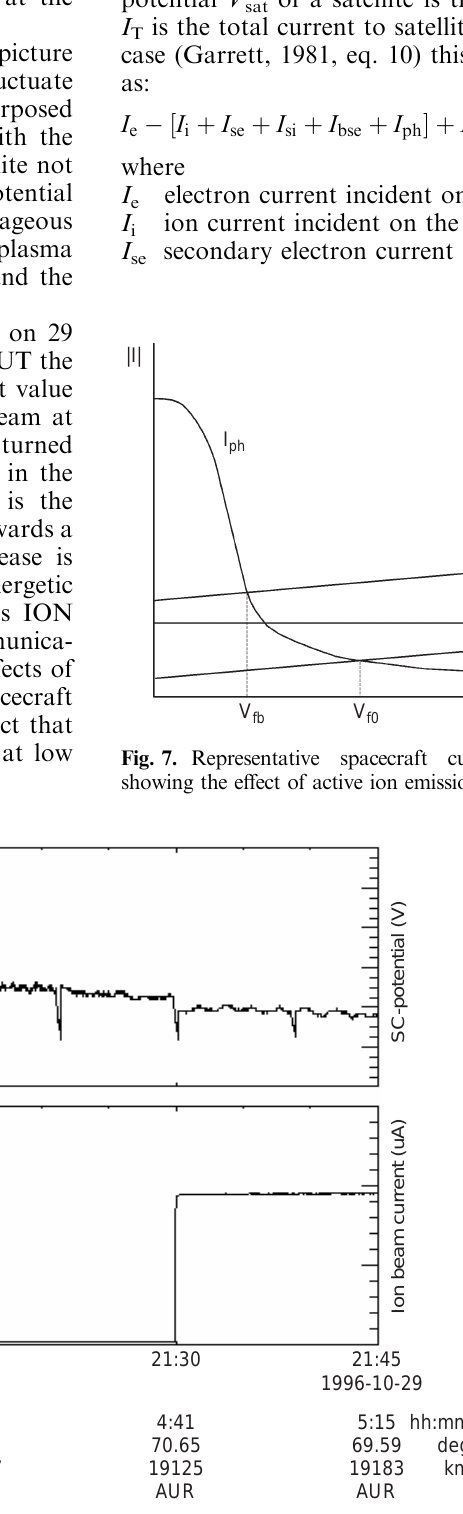
Fig. 6. Same as Fig. 5, but for 29 October, 1996, 20:45–21:45 UT. The five short drop-outs in the potential are instrumental artefacts